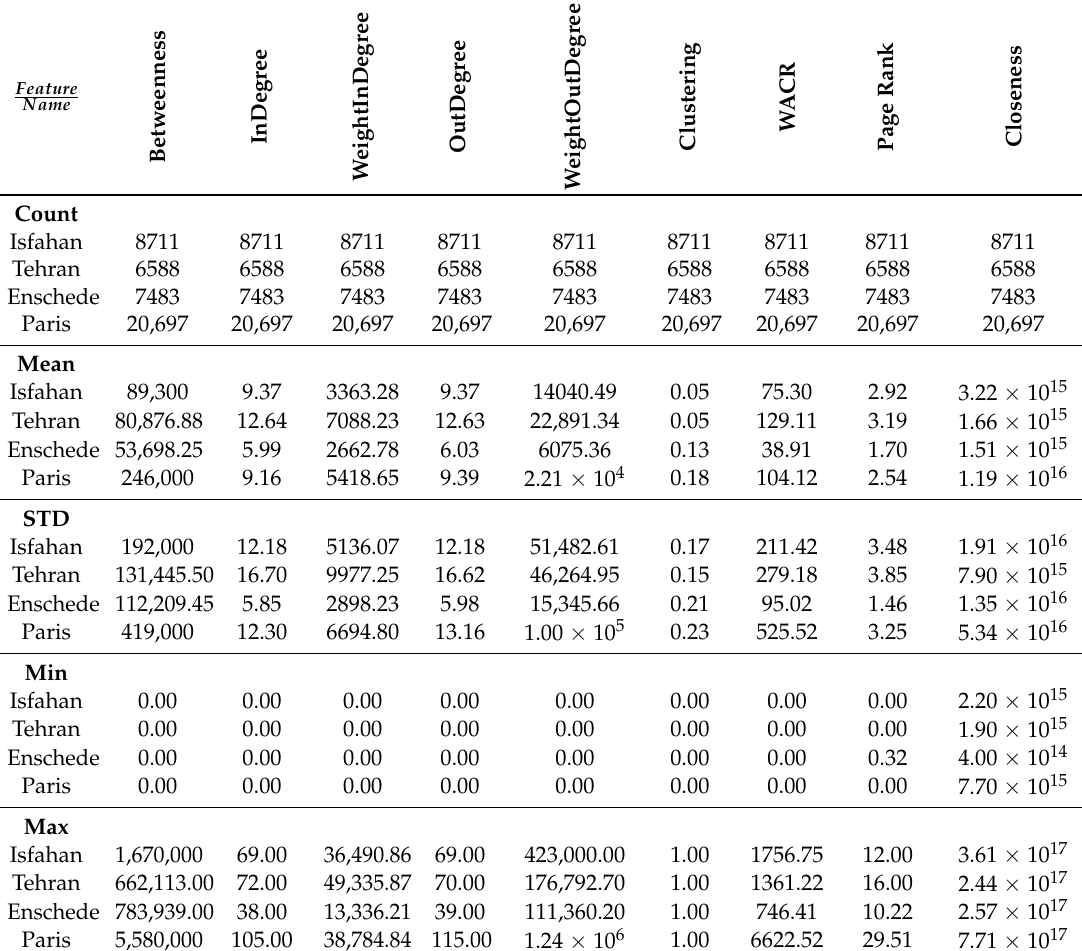
Table 1. Statistical summary of centrality measure data for all